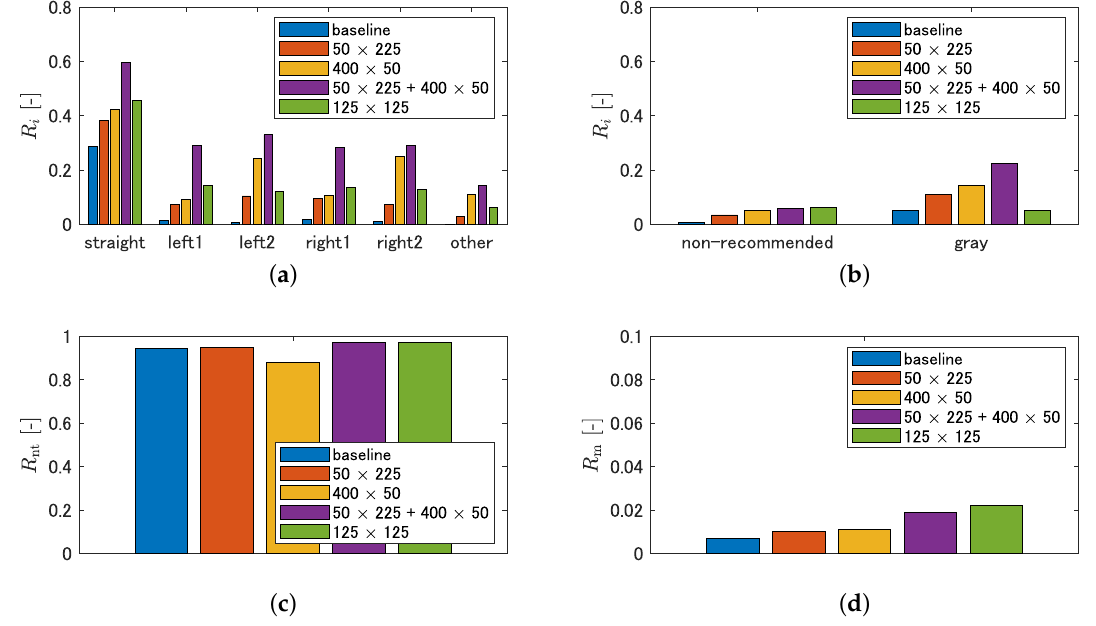
Figure 13. Quantitative evaluations of effectiveness of cropping: ( a ) detection rate of recommended area; ( b ) detection rate of non-recommended area and gray area; ( c ) detection rate of non-traversable area; and ( d ) misclassification rate of non-traversable